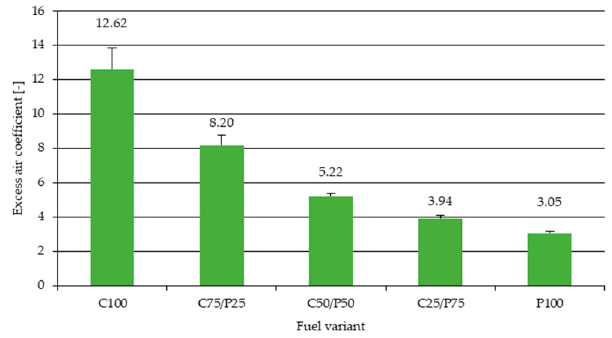
Figure 11. Dependence of the excess air coefficient on fuel variant.